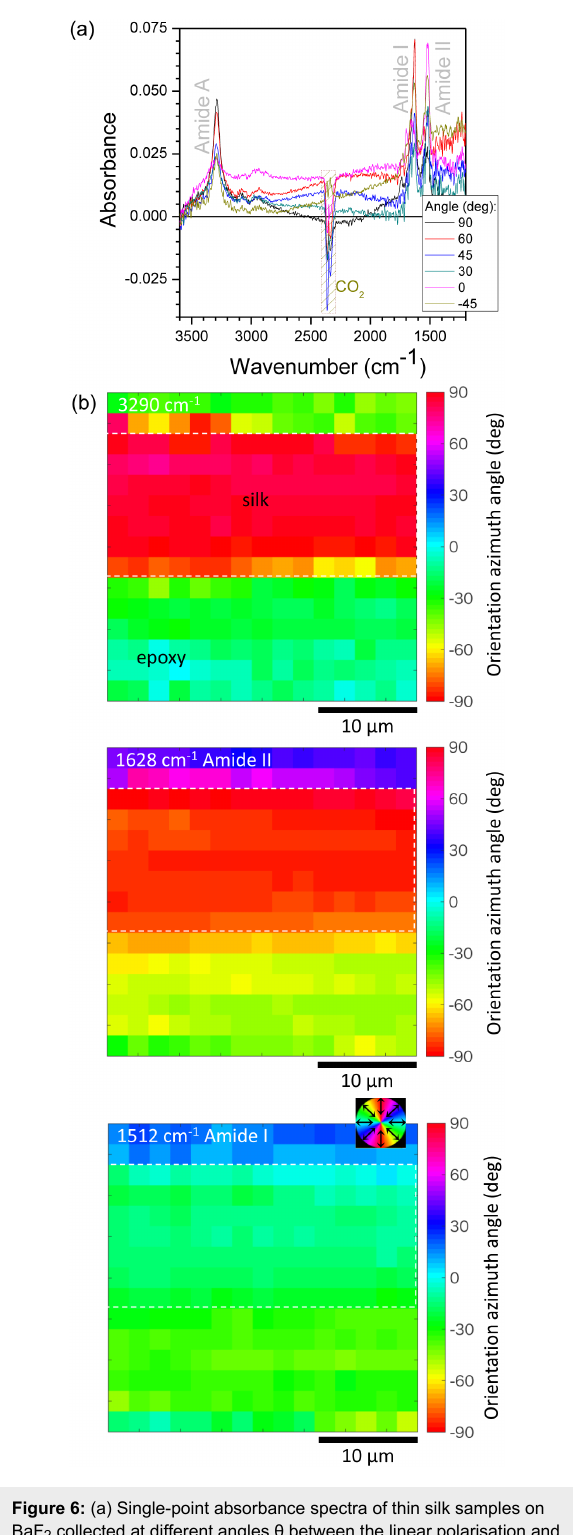
Figure 6: (a) Single-point absorbance spectra of thin silk samples on BaF 2 collected at different angles θ between the linear polarisation and the fiber axis, using 2 μ m pixel pitch, 15 × 15 pixel points, 4.17 μ m spatial resolution, and 4 cm − 1 spectral resolution. (b) Orientation color maps indicating that amide A (N–H) is oriented perpendicular to amide I (C=O) and amide II